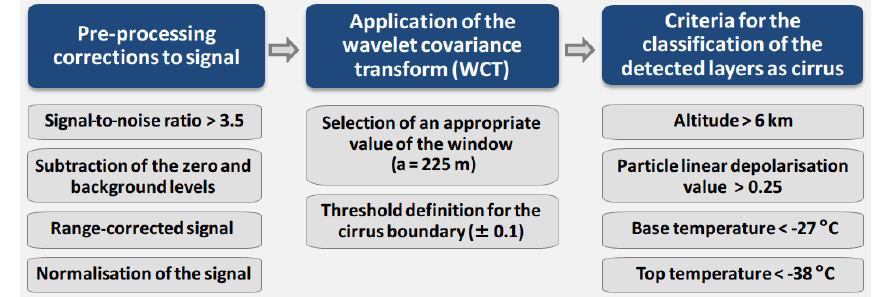
Figure 2. Schematic flow chart showing the main steps of the methodology applied in this study to obtain the cirrus geometrical boundaries from the Polly XT measurements.